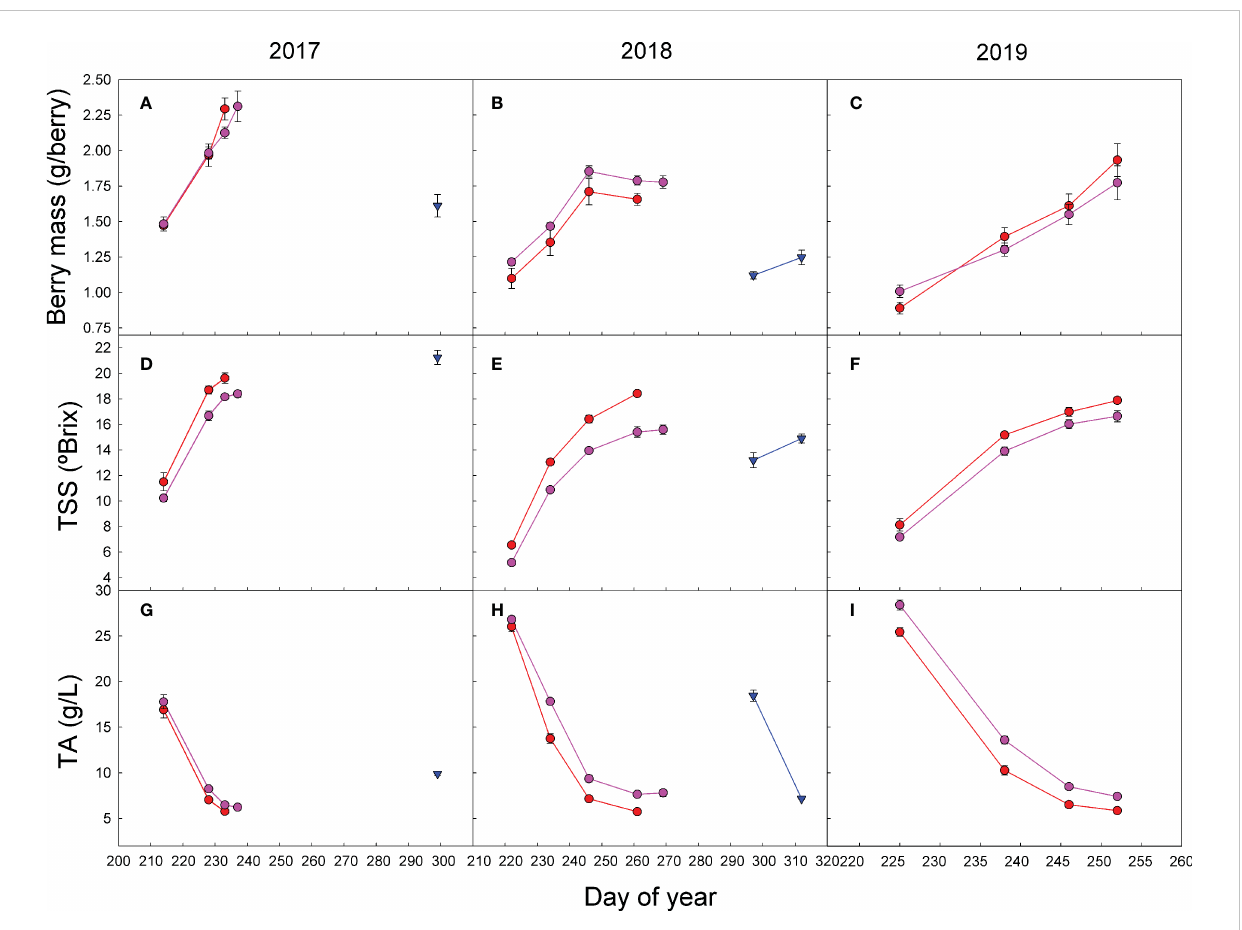
FIGURE 4 Effect of shading ( (cid:129) ), double pruning ( ▼ ), and control ( (cid:129) ) treatments on the seasonal evolution of (A – C) fresh berry mass; (D – F) total soluble solids (TSSs); and (G – I) the total acidity (TA) of ‘ Macabeo ’ grapes in (A, D, G) 2017, (B, E, H) 2018, and (C, F, I) 2019 seasons. Data are the average and SE offour values per treatment and